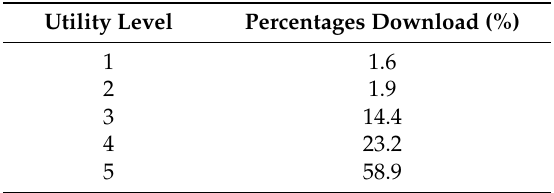
Table 9. Utility levels as users of DEM.